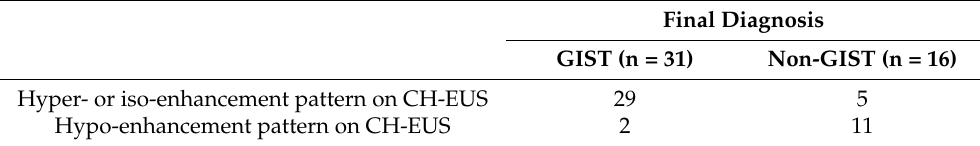
Table 3. Correlation between hyper- or iso-enhancement pattern on CH-EUS and GISTs.